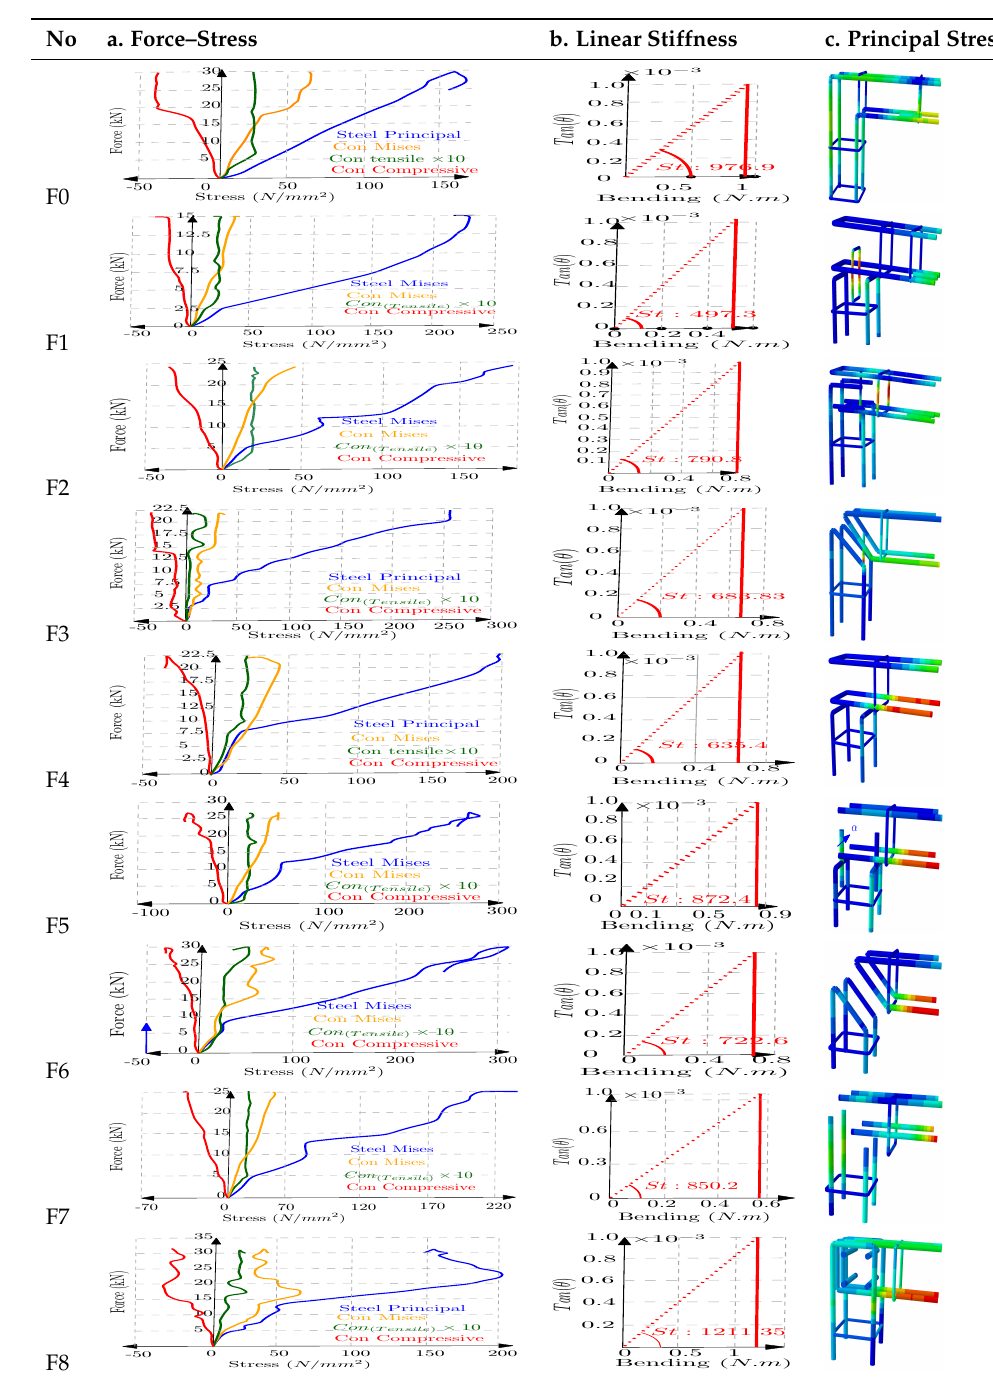
Figure A2. ( a ) Stresses–deformation, ( b ) bending deformation (stiffness) and ( c ) principal steel